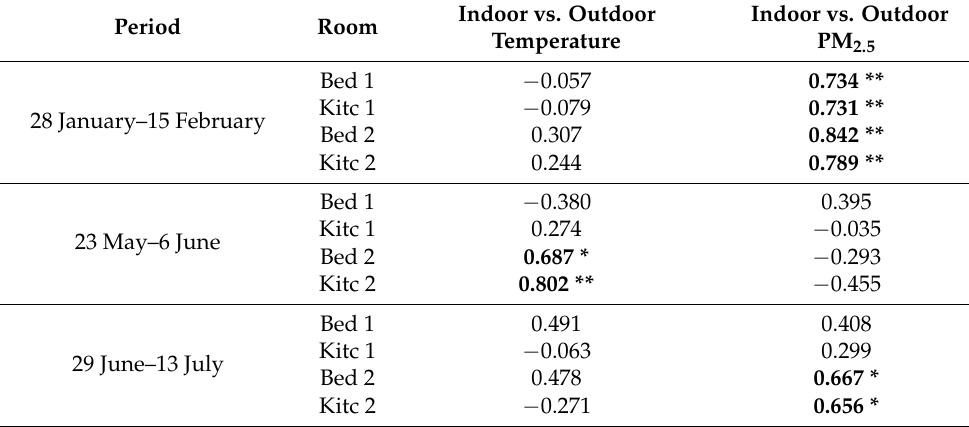
Table 4. Pearson’s coefficients of correlation between the different indoor and outdoor parameters measured during each monitoring campaign in each investigated room: indoor vs. outdoor Tempera- ture, indoor vs. outdoor PM 2.5 concentrations. Bold values represent Pearson’s coefficient significant at p < 0.05 level. Indoor vs. Outdoor Indoor vs. Outdoor Period Room Temperature PM 2.5 Bed 1 − 0.057 0.734 ** Kitc 1 − 0.079 0.731 ** 28 January–15 February Bed 2